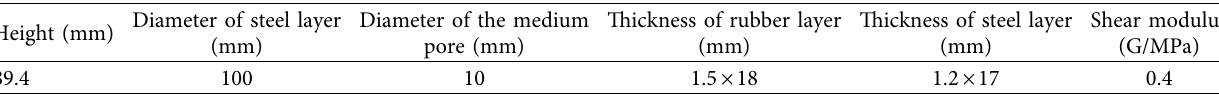
Figure 2: Sketch of isolation bearing. Table 1: Parameters of isolation